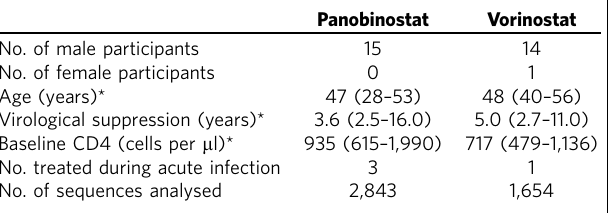
Table 1 | Baseline characteristics of study